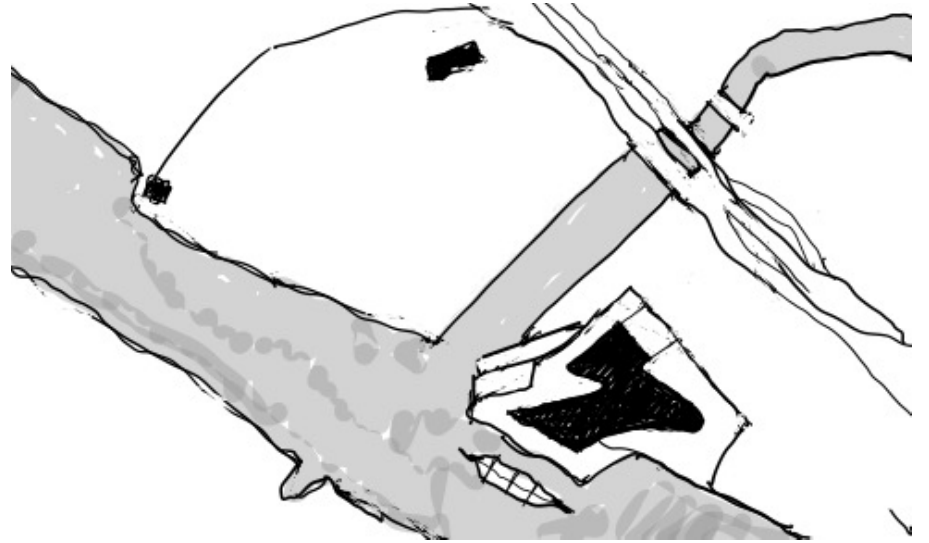
Figure 2. Situation of Riverside Museum in Glasgow at the intersection of the rivers Clyde and Kelvin. Building footprint in black (bottom, right-of-center) surrounded by open spaces, parking, and bounded by highways at the top. (Drawing by N.A. Salingaros)